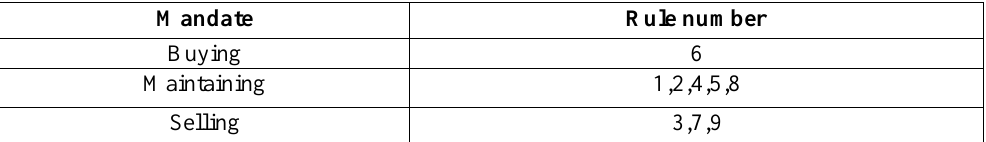
Table 4. The first rules